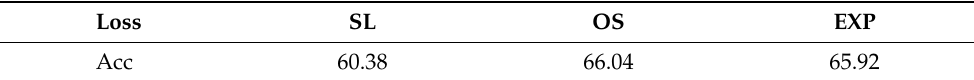
Table 5. Test accuracies (%) on the clean WebVision validation set of ResNet-50 models trained on WebVision. SL refers to a training schedule with a small learning rate that remains constant throughout the training process. OS (one-step) denotes a training schedule where the learning rate starts at a high value and then drops to a smaller value after a specified number of training steps. Exp refers to a training schedule where the learning rate decreases exponentially as the training